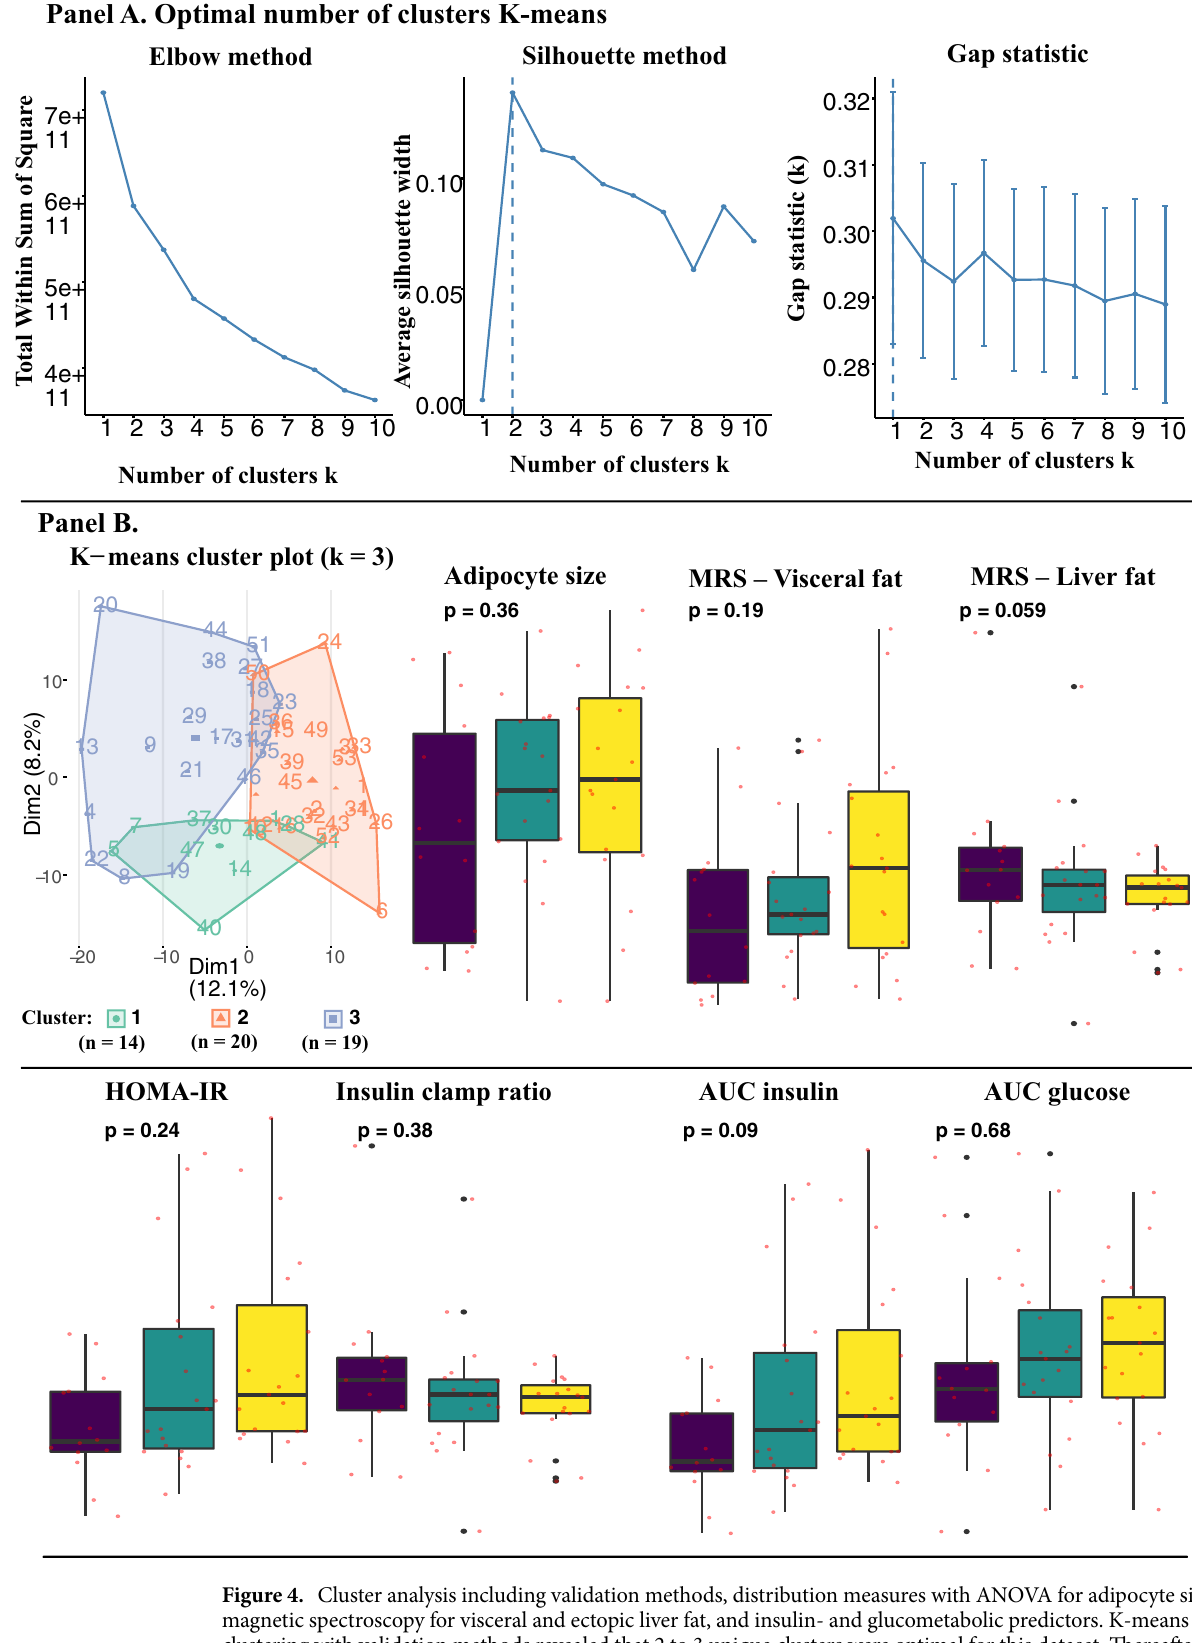
Figure 4. Cluster analysis including validation methods, distribution measures with ANOVA for adipocyte size, magnetic spectroscopy for visceral and ectopic liver fat, and insulin- and glucometabolic predictors. K-means clustering with validation methods revealed that 2 to 3 unique clusters were optimal for this dataset. Thereafter, mean values for predictors of interest in this study was examined and ANOVA was performed to identify significant differences in mean